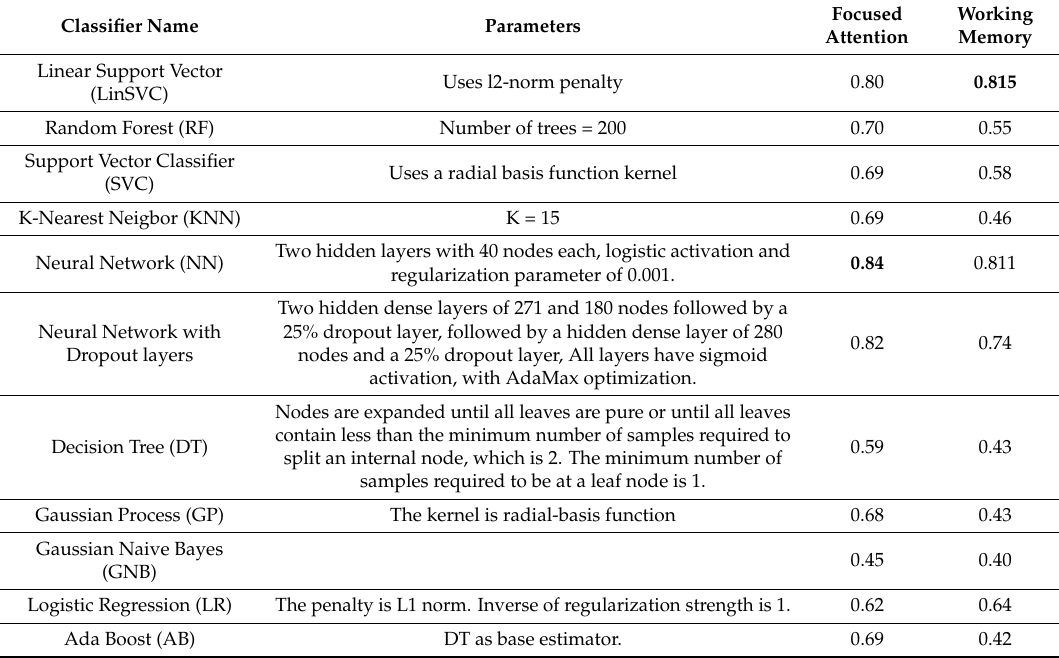
Table 2. Summary of the average scores of stratified 10-fold cross validation for the two cognitive skills using statistical and frequency domain features. Highest scores are shown in